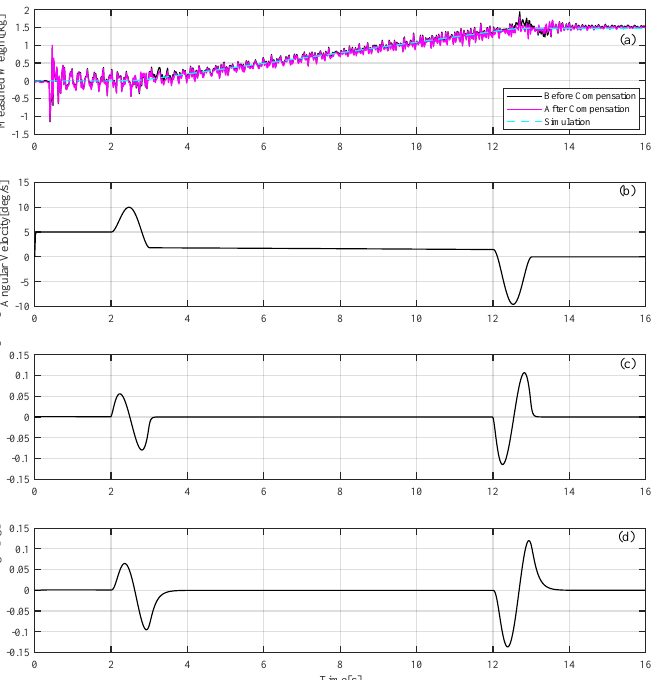
Figure 6. Experimental results of the weight compensation system. ( a ) Weight data measured by load cell; ( b ) Angular velocity of ladle tilting; ( c ) Acceleration on z -axis estimated by SSKF; ( d ) Weight data transformed from estimated acceleration on z -axis using Equation